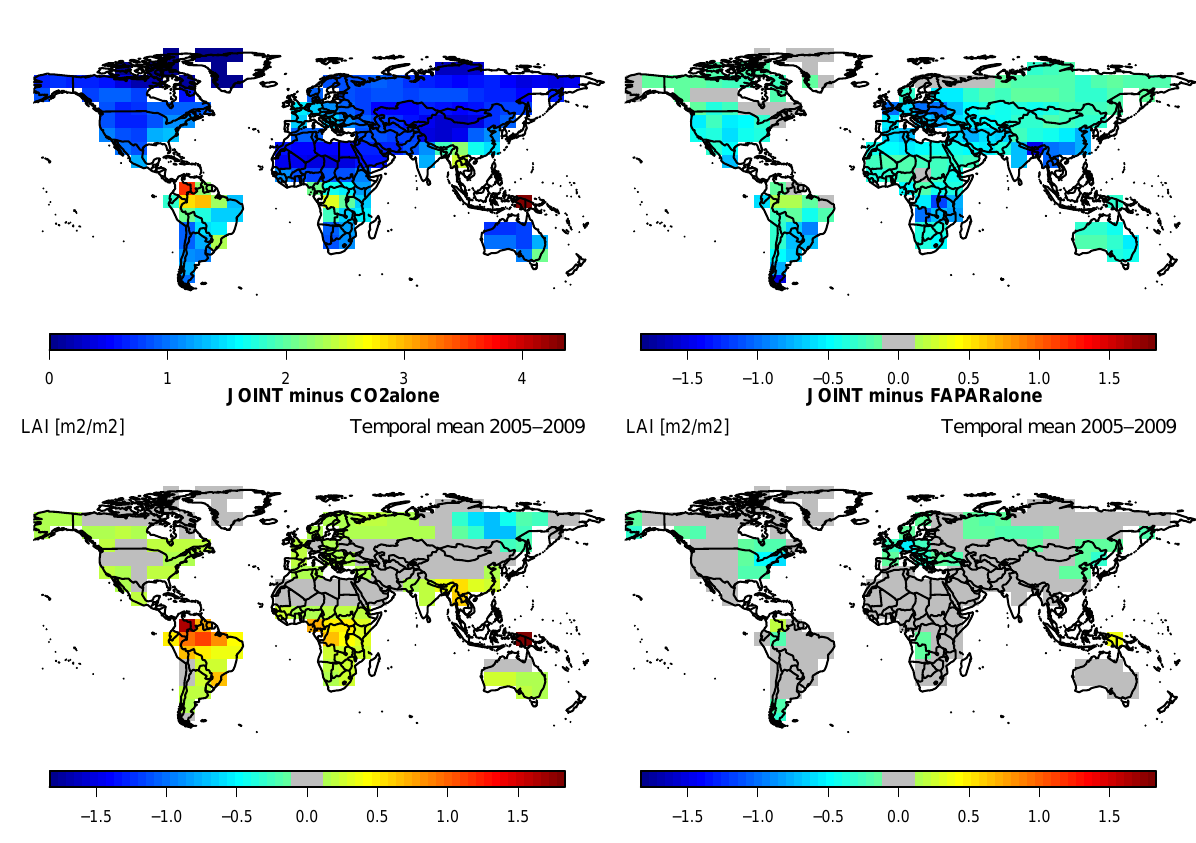
Figure 3. Temporally averaged global LAI of the JOINT experiment and differences of the other experiments to the JOINT case. data agreement, since these PFTs only cover a small fraction of the global land